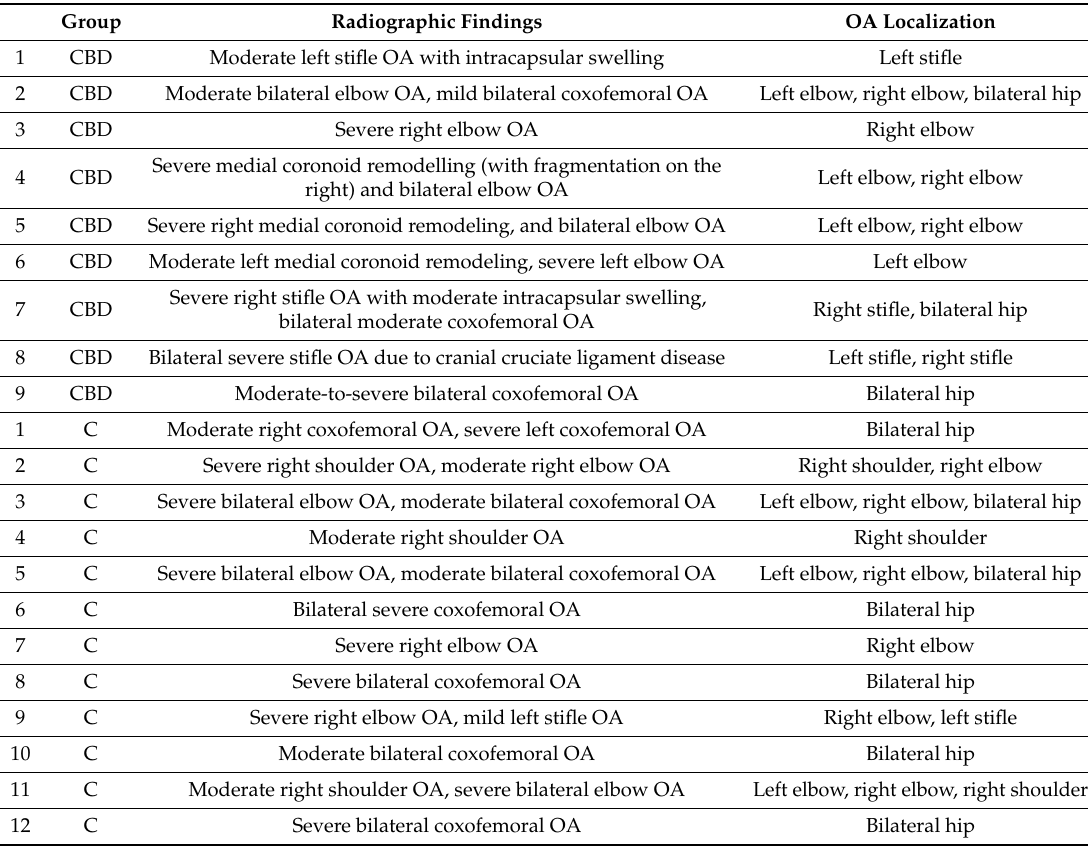
Table 1. Radiographic findings and osteoarthritis (OA) involved joint of the dogs recruited in cannabidiol (CBD) ( n = 9) and C ( n = 12)